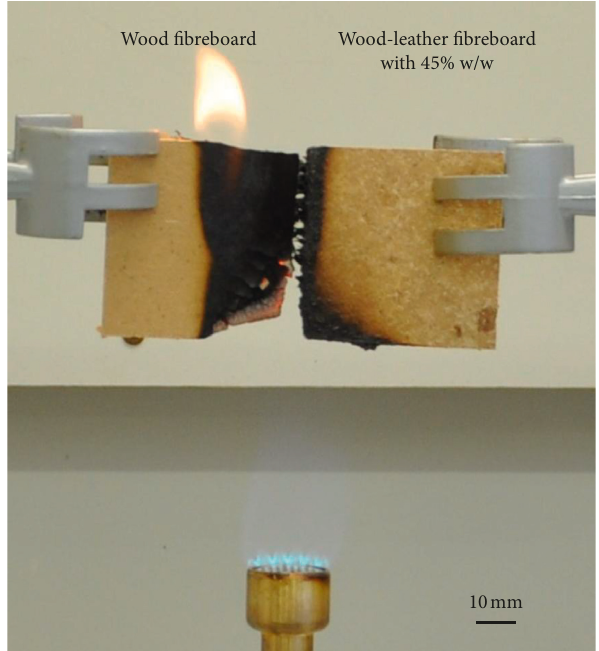
Figure 2: Combustion test of wood (left) and wood-leather (right) fibreboards by using a Bunsen